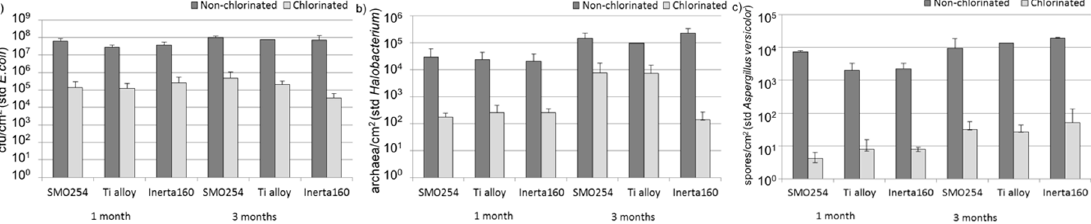
Figure 2. Quantity of ( a ) bacteria; ( b ) archaea ( c ) and fungi, on the coupon surfaces, determined using quantitative PCR. Bars show standard deviations.